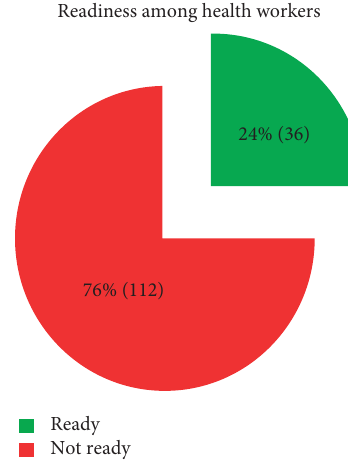
Figure 2: Level of readiness among healthcare